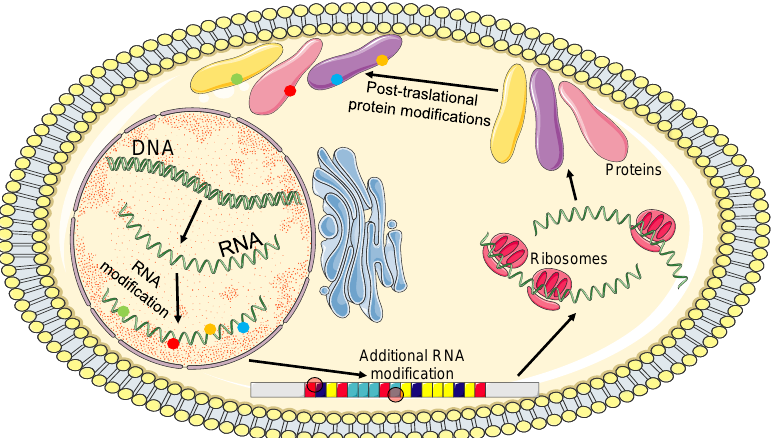
Figure 2. Potential sites of RNA modifications. DNA: deoxyribonucleic acid, RNA: ribonucleic acid. See text for details.